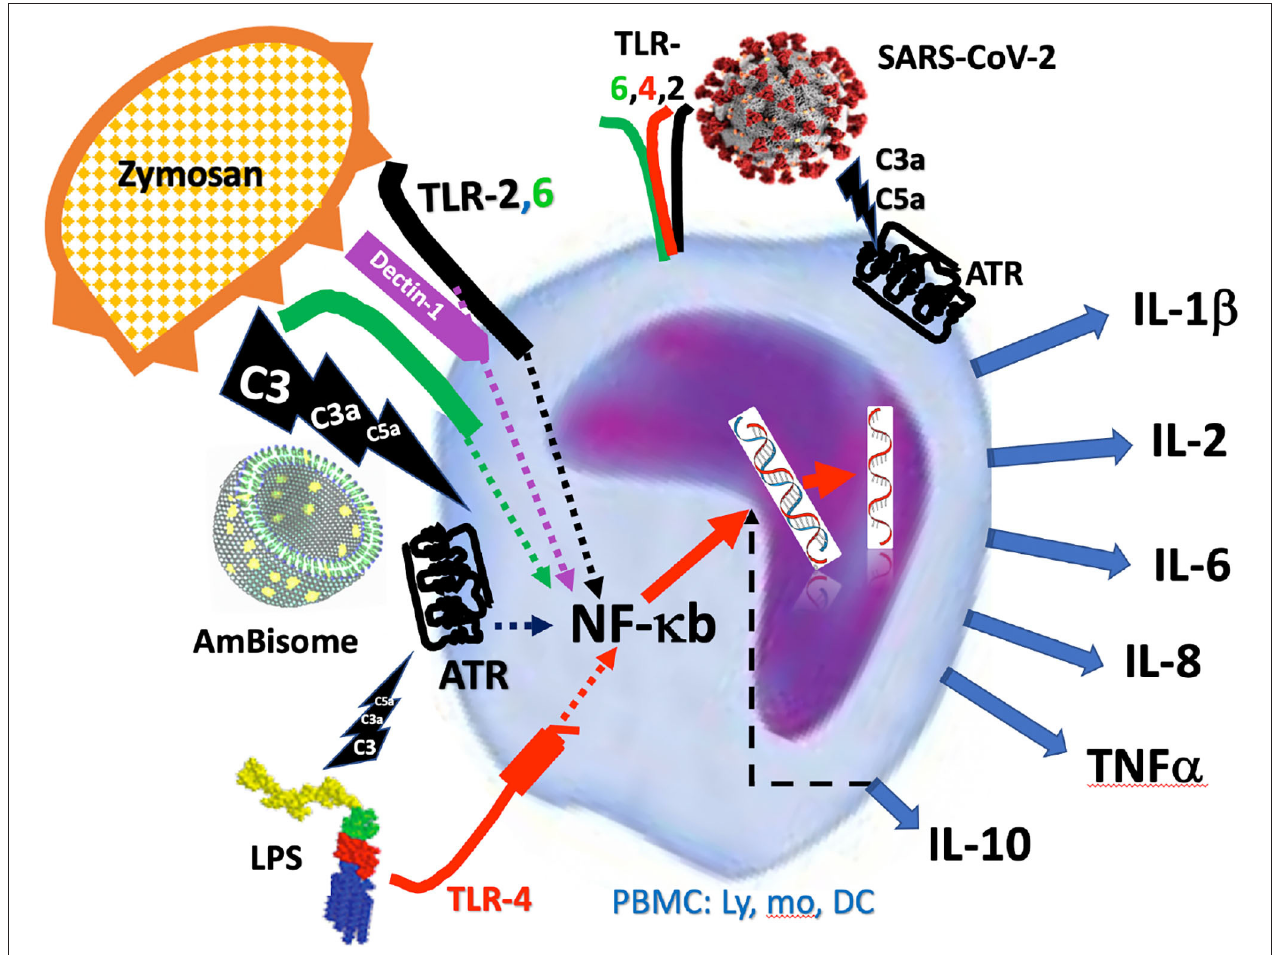
FIGURE 6 | Schematic illustration of activation of PBMC by zymosan, AmBisome and LPS via simultaneous engagement of anaphylatoxin and Toll-like receptors (ATR, TLR). The intracellular signaling of activator-receptor binding merges into NF- κ b-mediated de novo transcription of inflammatory cytokines, explaining the complement inhibition-sensitive production of cytokines. The figure also reminds that the SARS-CoV-2 may also induce cytokine release via additive, or synergistic stimulation of both the ATR and Toll-like receptors, making the process complement-